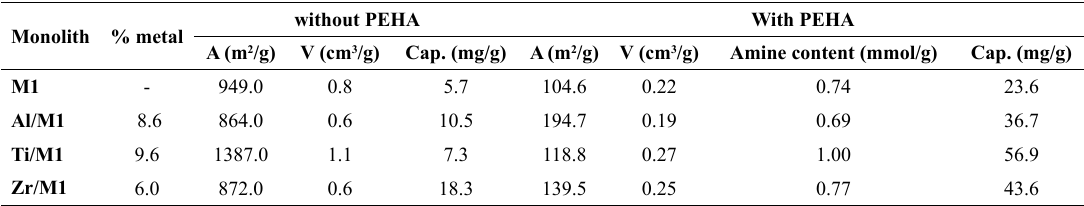
adsorption capacity of 2